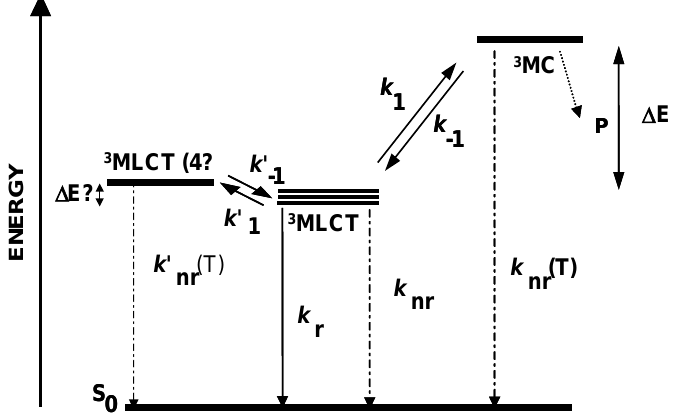
Figure 1. Simplified excited state deactivation diagram for a Ru(II) complex with polyazaheterocyclic chelating ligands. The picture depicts only the emitting and the thermally-activated (dark) excited states.